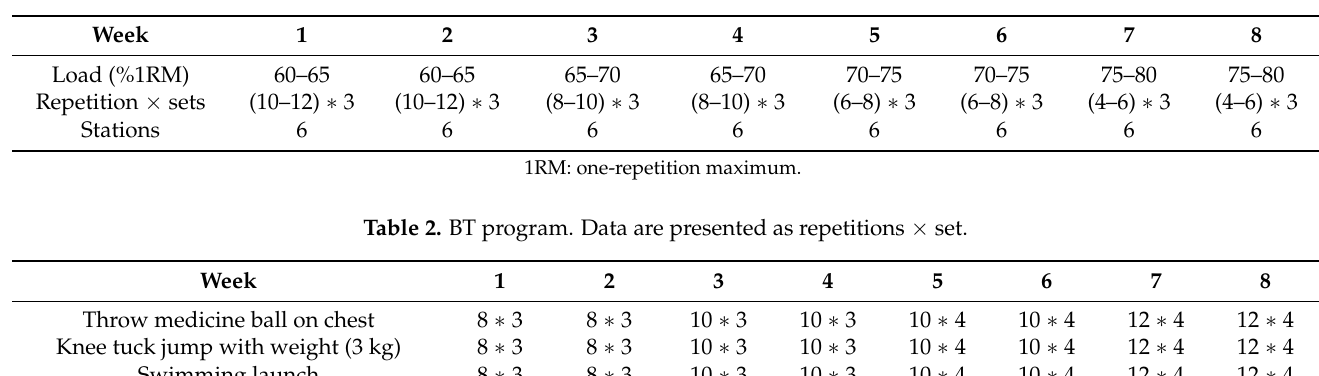
Table 1. PT program.